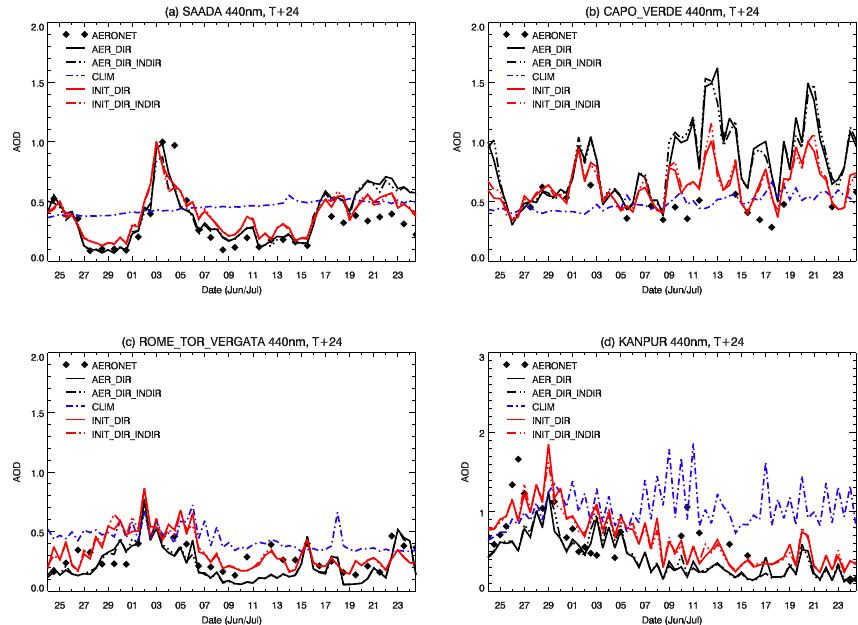
Fig. 4. Time series of T + 120 forecast AOD (440nm) in locations where anthropogenic aerosol is predominant: (a) Paris, (b) Rome, (c) Fig. 4. Timeseries of T +120 forecast AOD (440 nm ) in locations where anthropognenic aerosol is predominant (a) Paris, (b) Rome, (c) Kanpur and (d) Hong Kong. Kanpur and (d) Hong Kong.